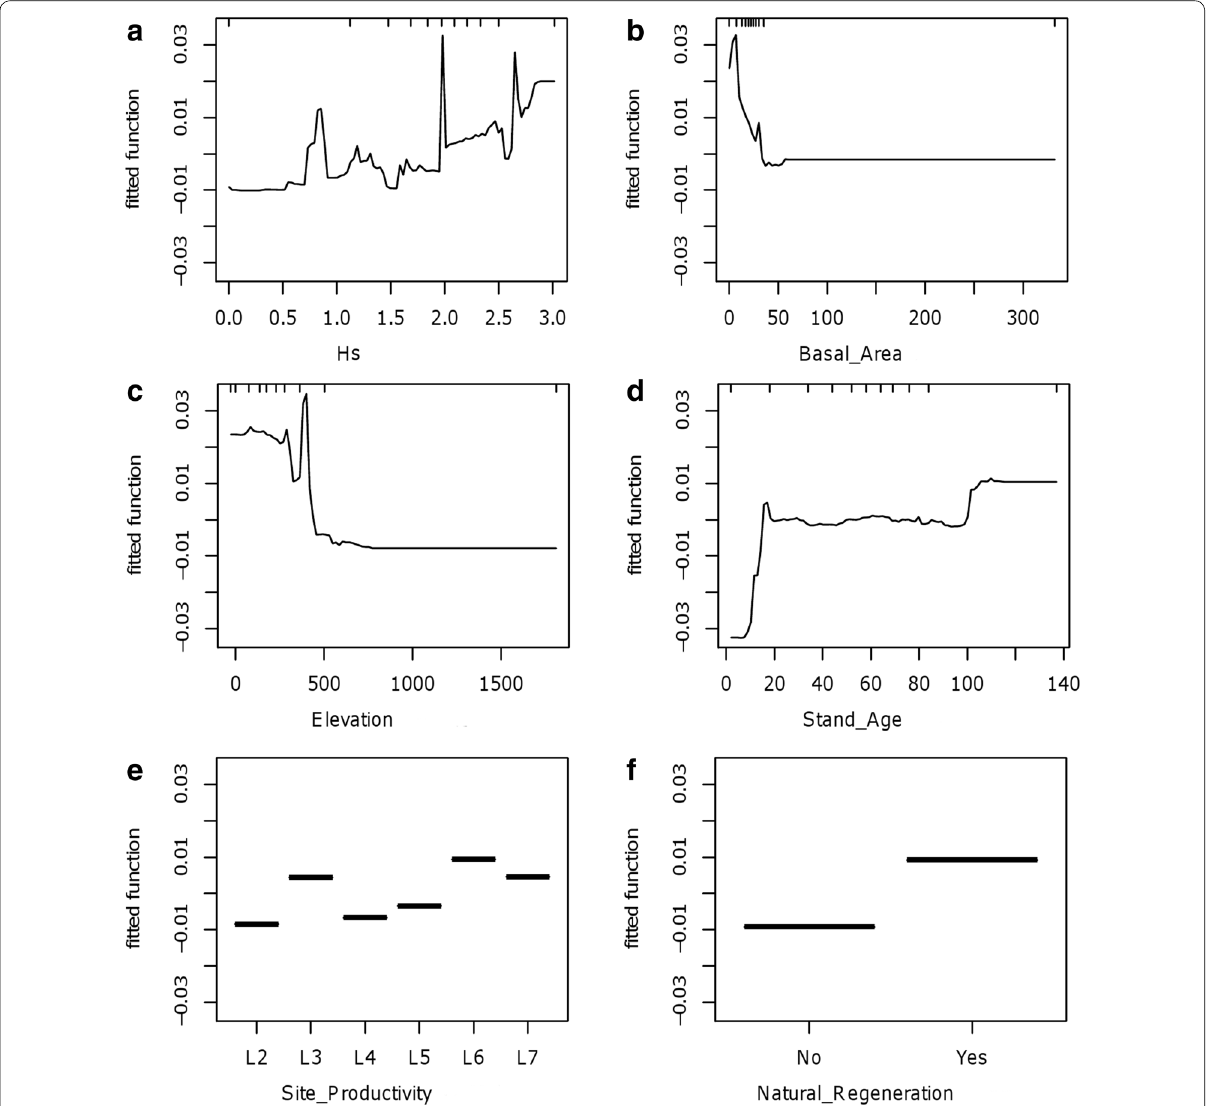
Fig. 3 Partial dependence plots for the explanatory variables included in the optimal boosted regression tree model for Japanese stiltgrass presence based on analyses of the six most influential variables. Hash marks at the top of plot a – d indicate distribution of sample plots along the range of the indicated variable. There is no hash mark at the top of plot e and f because the partial dependence plots represent categorical variables. X‑axes indicate influential variables and their relative contributions (%) in the final model (see Table 1 for the description of variables). Y‑axes are based on the logit scale used for the indicated